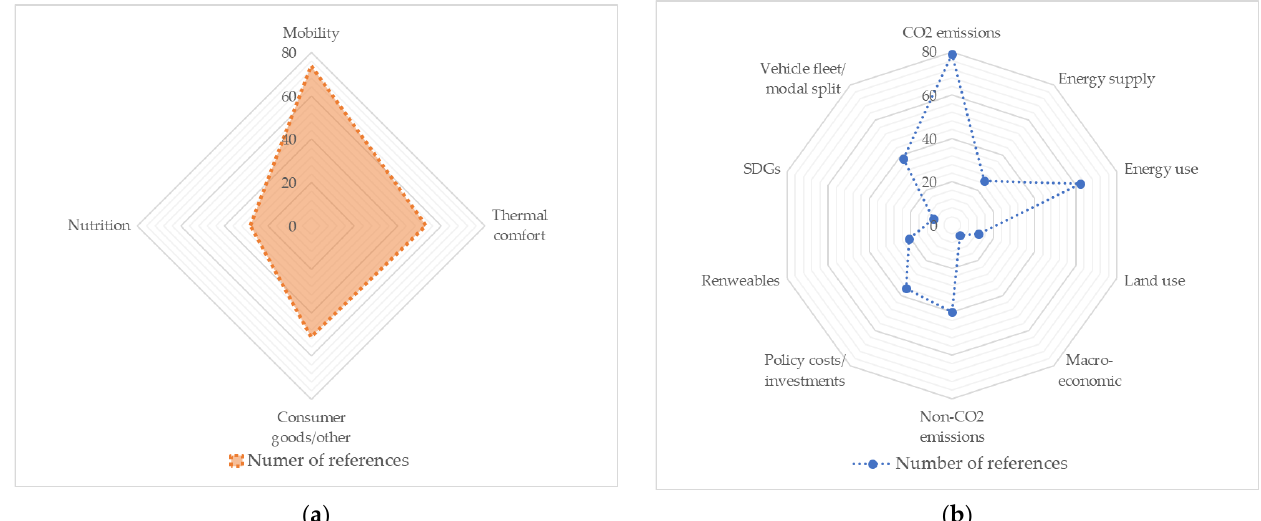
Figure 4. Descriptive statistics of reviewed papers with respect to the ( a ) type of investigated behav- ioral measures and ( b ) indicators used to quantify lifestyle effects. behavioral measures and ( b ) indicators used to quantify lifestyle